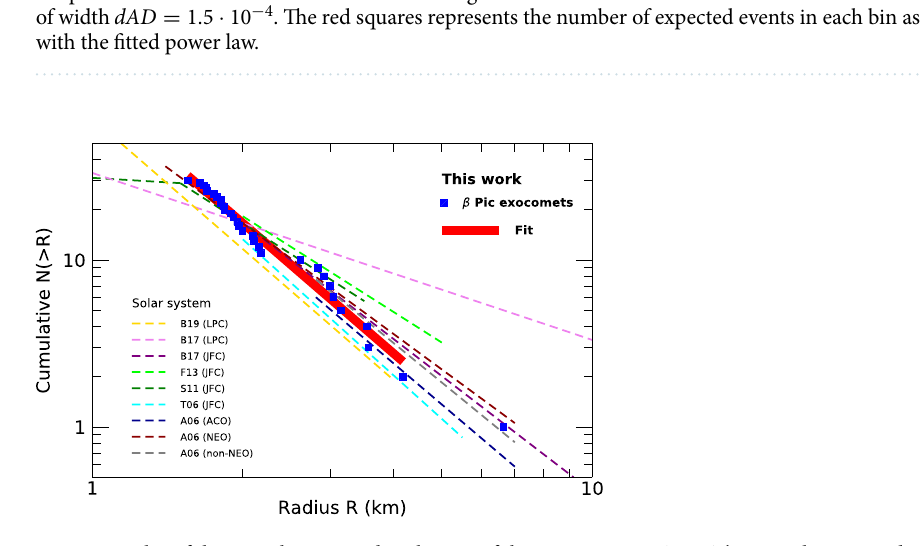
Figure 2. Plot of the cumulative size distribution of the exocomets in β Pic. The cumulative size distribution is plotted with blue squares for each exocomet and the corresponding fit excluding the largest comet is plotted with the red thick line. For comparison, published size distributions measured in the Solar system are plotted with thin dashed lines for asteroids in comets orbits (ACO), on near Earth orbits (NEO) and non-near Earth orbits (non-NEO) (A06, Ref. 31 ), Jupiter family comets (JFC) (T06, Ref. 26 ; S11, Ref. 27 ; F13, Ref. 29 ; B17, Ref. 30 ), and long-period comets (LPC) (B17, Ref. 30 ; B19, Ref. 25 ). In this plot, the size distributions for the objects in